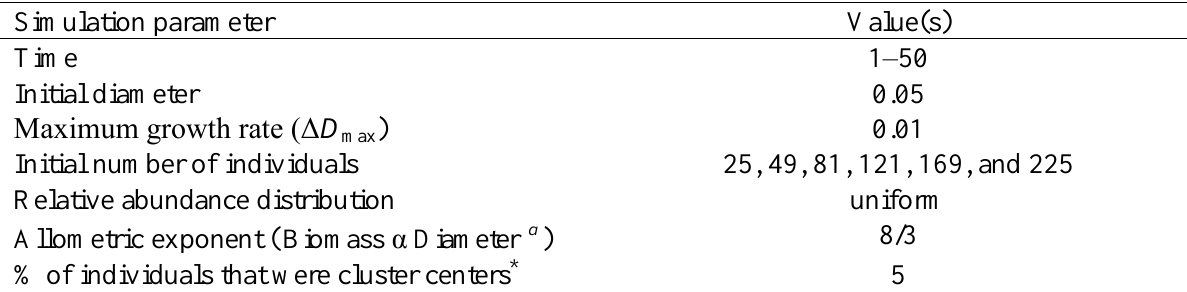
Table 1. Parameter values used to generate the results discussed in the